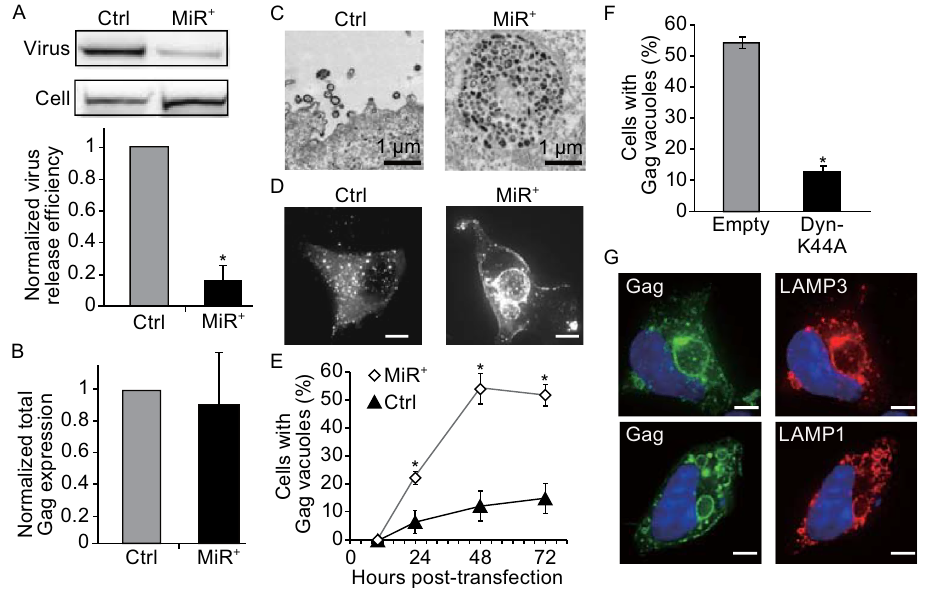
Figure 1. Overexpression of non-silencing miRNAs causes redistribution of HIV-1 Gag complexes from the PM to lysosomes through endocytosis. (A) The effect of overexpressing non-silencing miRNAs on virus particle release in MiR + and Ctrl cells at 48 h post-transfection of pNL43 Δ P Δ E. Western blot was performed with pooled Ig from HIV-1-infected patients (HIV-Ig) to detect Gag in viral particles and cells. Virus release ef fi ciency was calculated as described in MATERIALS AND METHODS, normalized to virus release ef fi ciency in Ctrl cells. (B) Total Gag expression levels (virus Gag plus cellular Gag) measured by Western blot in MiR + and Ctrl cells after transfection with pNL43 Δ P Δ E, normalized to total Gag expression in Ctrl cells. (C) Representative electron micrograph images of MiR + and Ctrl cells transfected with pNL43 Δ P Δ E. Characteristic Gag-enriched viral buds are observed at the PM of Ctrl cells, while MiR + cells tend to form large intracellular vacuoles. (D) Representative fl uorescence images of Gag expression in MiR + and Ctrl cells through pNL43 Δ P Δ E-Gag-EGFP transfection. (E) Post-transfection time-course quanti fi cation of the percentage of cells with intracellular Gag-enriched vacuoles with diameter greater than 1 μ m. (F) Co-transfection of pNL43 Δ P Δ E-Gag-EGFP with Dyn-K44A, a dominant-negative mutant that inhibits endocytosis, but not with empty vector, led to signi fi cant reduction in Gag vacuole formation. (G) Representative images of LAMP3 and LAMP1 in MiR + cells expressing pNL43 Δ P Δ E-Gag-EGFP. LAMP3 and LAMP1 colocalize extensively with Gag-EGFP in large vacuoles. Data represent mean ± SD of at least three replicates. Each replicate experiment was performed by examining at least 200 transfected cells. Unless otherwise noted, scale bar = 10 μ